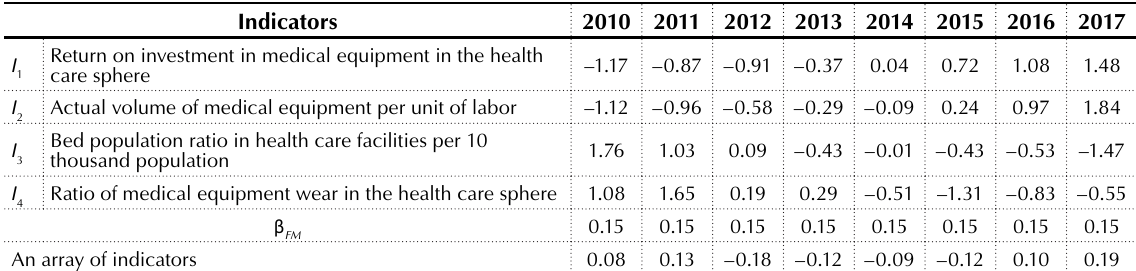
Table 4. Calculation of the socio-economic potential of health insurance/an array of indicators of the material resource management (specified values)